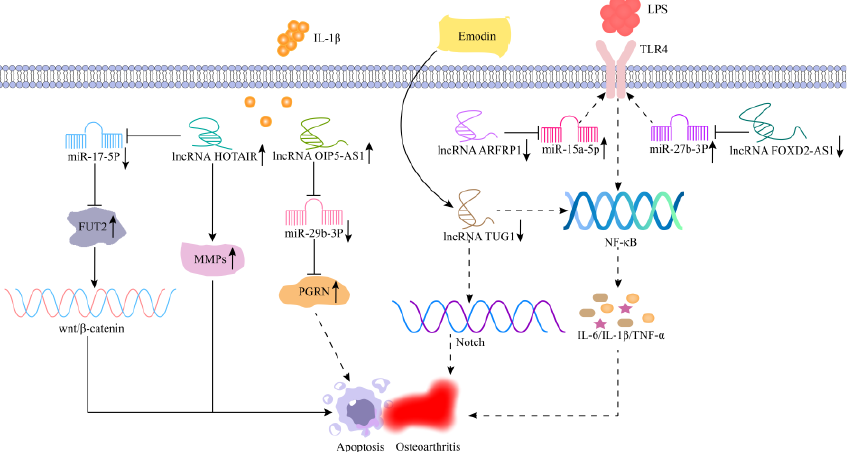
Figure 7. Mechanism of lncRNAs in osteoarthritis. In IL- 1β -induced OA model, overexpression of lncRNA HOTAIR promotes the expression of MMPs and exacerbates OA. Overexpression of lncRNA HOTAIR increases the activity of Wnt/β -catenin pathway by regulating miR-17-5p/FUT2 axis, which aggravates the injury and apoptosis of chondrocytes. Overexpression of lncRNA OIP5-ASI inhibits apoptosis and inflammation by targeting miR-29b-3p/PGRN. Emodin inhibits the Notch/NF- κB pathway by upregulating lncRNA TUG1 , which alleviates the apoptotic and inflammatory response of chondrocytes. LncRNA ARFRP1 is significantly upregulated in LPS-induced chondrocytes, and the downregulation of lncRNA ARFRP1 inhibits activation of NF- κB signaling pathway by targeting miR-15a-5p/TLR4 axis. Knockdown of lncRNA FOXD2-AS1 alleviates inflammatory injury by regulating the miR-27a-3p/TLR4 axis.